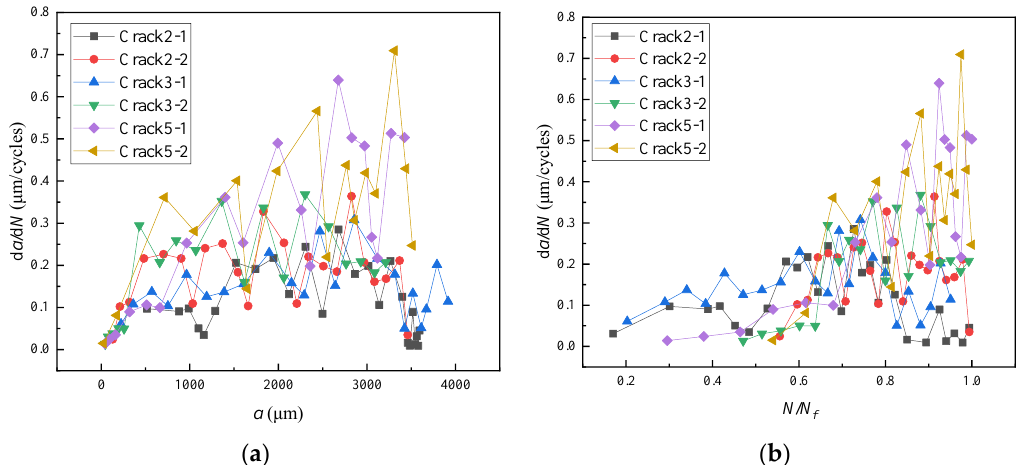
Figure 16. Variation of crack growth rate of cruciform specimen with circular notch in the central area. ( a ) Variation of crack growth rate with crack length. ( b ) Variation of crack growth rate with cycle ratio.